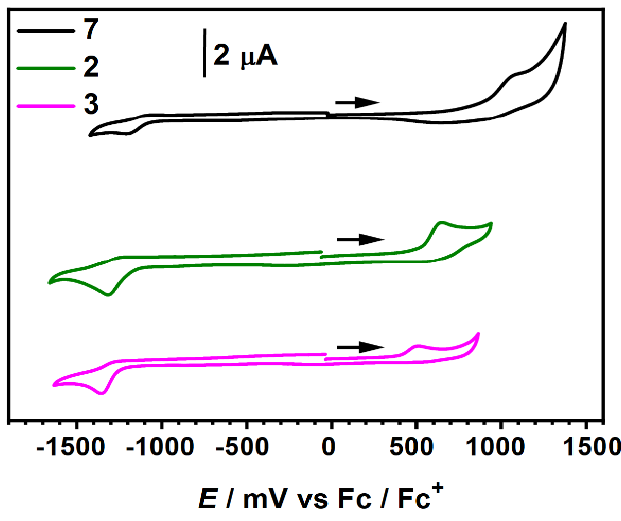
Figure 7. Cyclic voltammogram of 2 , 3 and 7 calibrated vs. ferrocene/ferrocenium (Fc/Fc + ) ( c ~ 10 − 4 –10 − 5 M in dry CH 2 Cl 2 ; scan rate = 100 mV s − 1 , 0.1 M Bu 4 NPF 6 as a supporting electrolyte, 50% iR